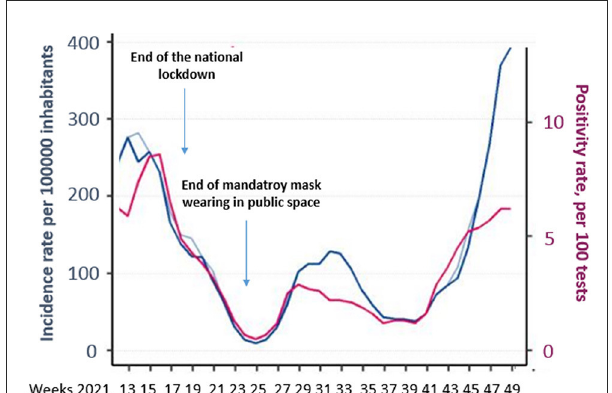
FIGURE1 Incidence of COVID-19 in the Pays de la Loire region throughout the study